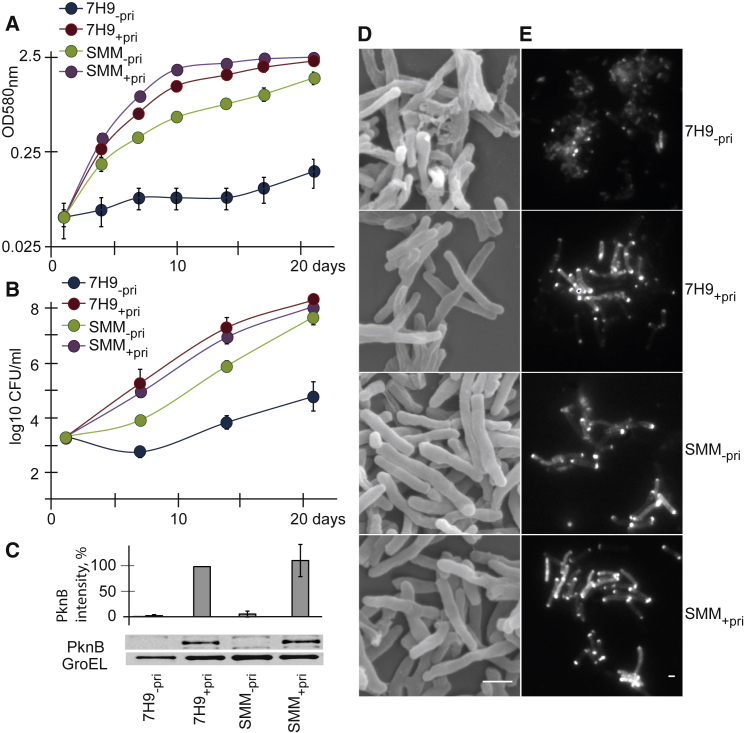
Osmoprotective Medium Supports Growth of a Conditional pknB Mutant(A–E) M. tuberculosis mutant was grown in standard 7H9 medium with (7H9+pri) or without (7H9−pri) pristinamycin or in sucrose-magnesium medium with (SMM+pri) or without (SMM-pri) pristinamycin at 37°C with shaking. Growth was monitored by (A) measurement of optical density at 580 nm and by (B) assessment of colony-forming unit (CFU) counts on 7H10 agar. Data are represented as means ± SEMs (n = 6).(C) PknB was detected using anti-PknB antibody; relative intensity of PknB bands presented as means ± SEMs (n = 3).(D) Scanning electron micrographs of M. tuberculosis bacteria.(E) Detection of nascent peptidoglycan by Van-BODIPY labeling. Scale bars, 1 μm.